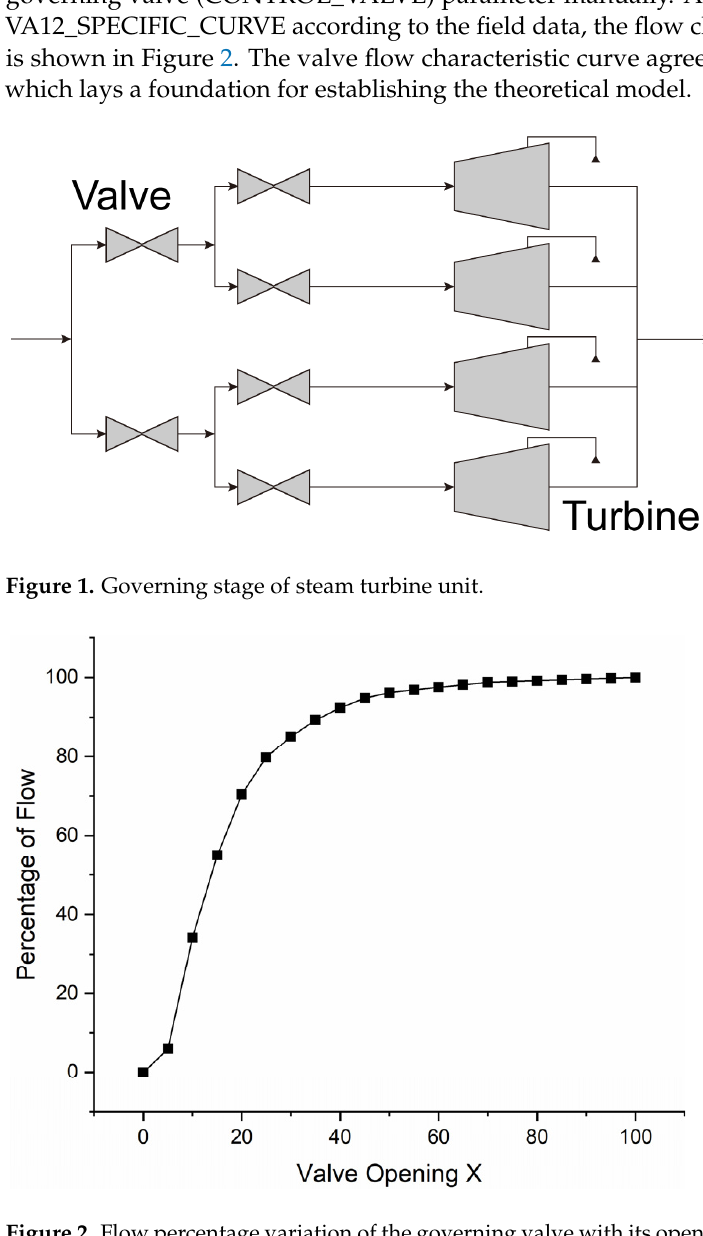
Figure 2. Flow percentage variation of the governing valve with its opening. The percentage in- creases with the increase in the opening. When the opening reaches 60%, the flow percentage maintains a stable state.